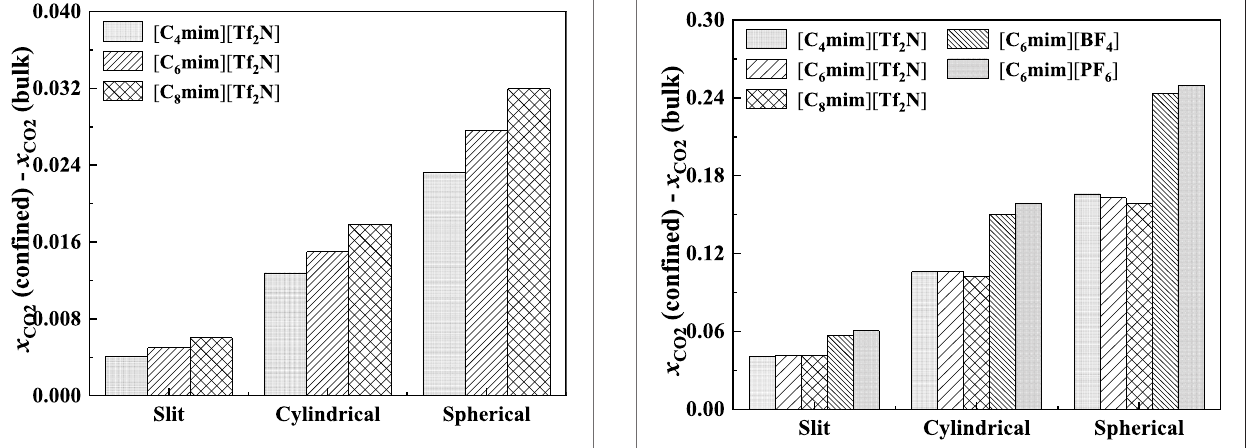
FIGURE 18 | Calculated additional solubilities of ILs in different-shaped pores at 298.15 K and 30 bar (the width of slit-shaped pore and the diameter of cylindrical pore and spherical cavity are all 5 nm).